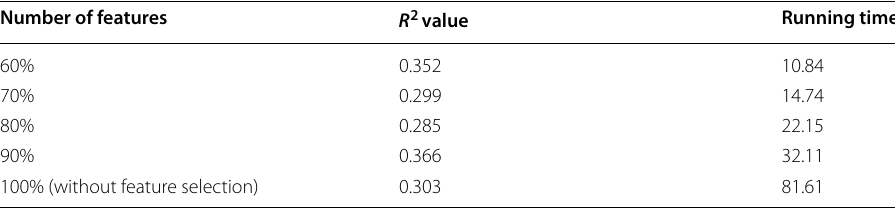
Table 6 QSAR-RFR(SPCA) simulation results on ECFP_4 dataset Number of features